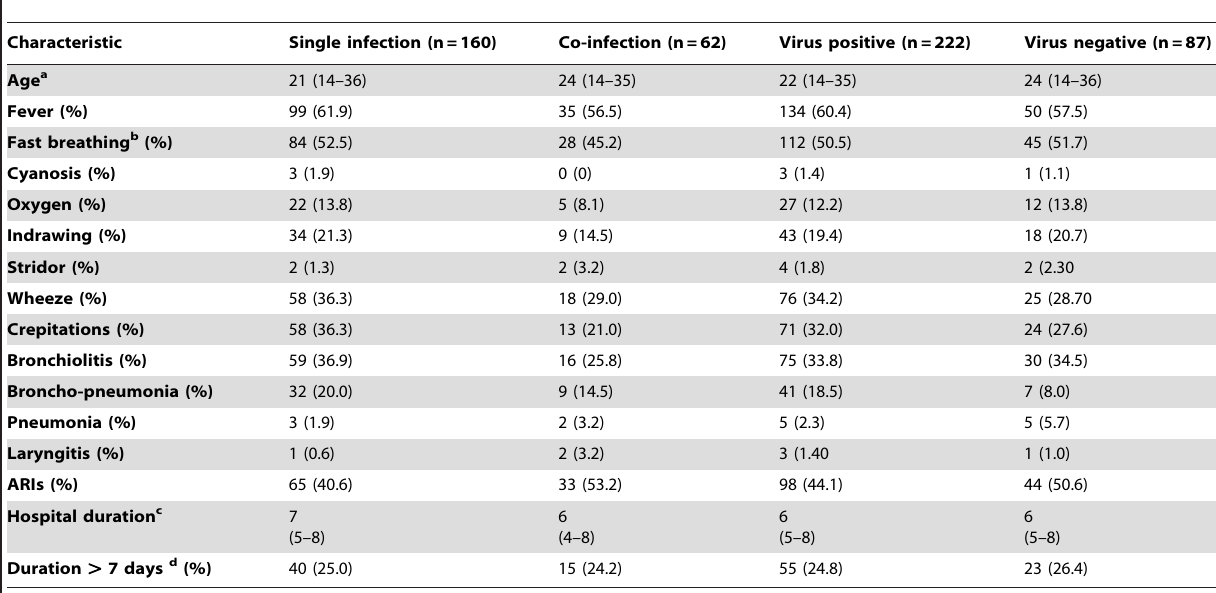
Table 5. Summary of associations between clinical characteristics and viral single/co-infection or viral positive cases and viral negative cases.